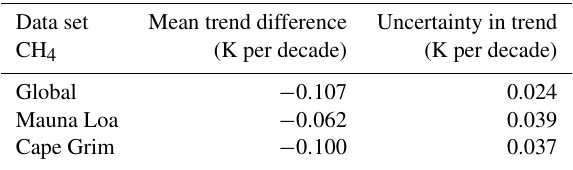
Table 6. Slope of the (AIRS – ESRL) CH 4 anomalies in K per decade